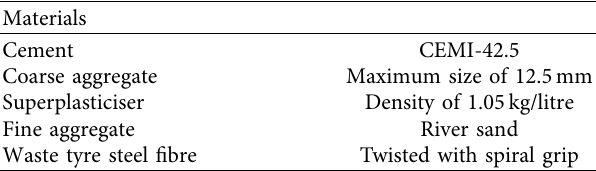
Table 1: Summary of materials used in the study. Materials